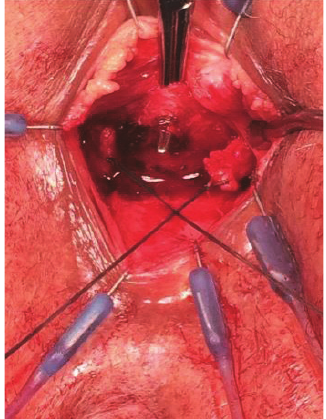
Figure 1: Tagged vaginal arms of transected TVT sling. The minisling has been dissected away from the suburethral tissue and isolated with a right-angle clamp prior to cutting in the midline. Permission to reprint from Miklos and